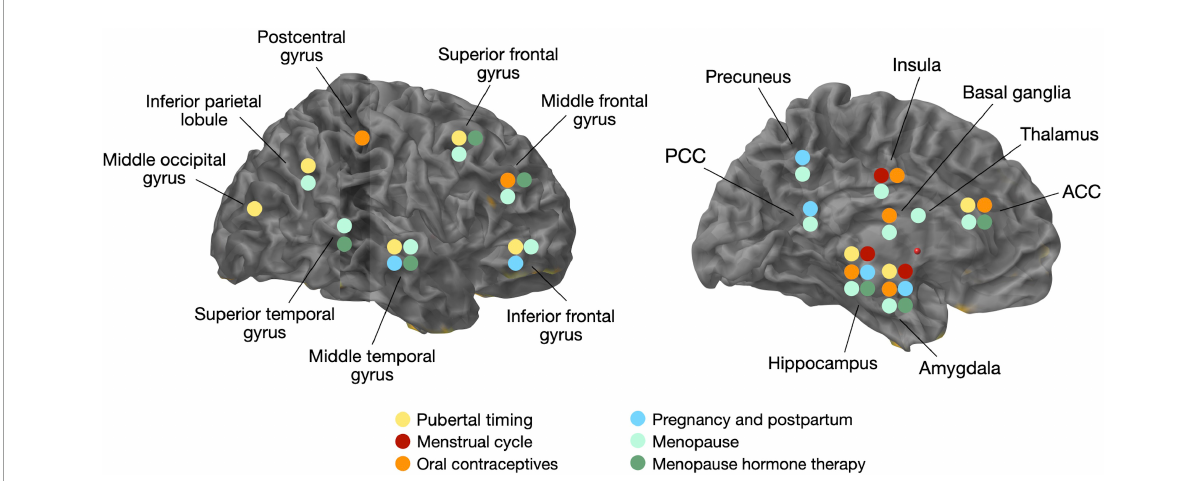
FIGURE1 Overview of volumetric gray matter changes related to changes in estradiol levels and/or hormonal transitions. ACC, anterior cingulate cortex; PCC, posterior cingulate